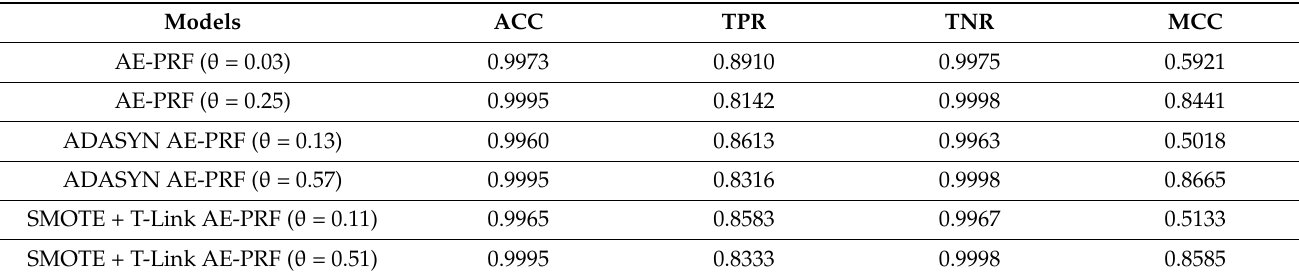
Table 2. Performance of AE-PRF with and without data resampling.